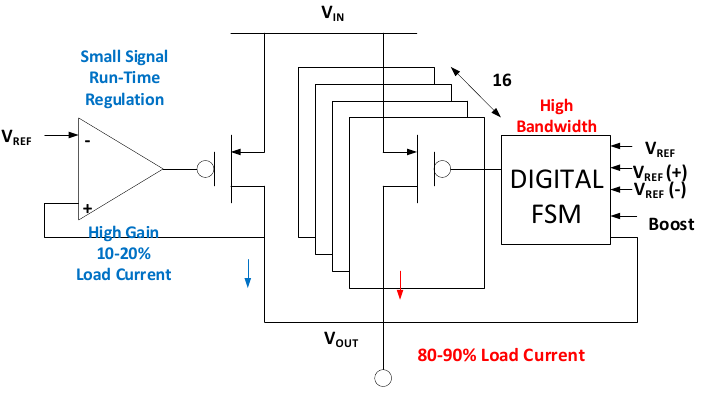
Figure 31. Basic Architecture of HD-LDO [58].